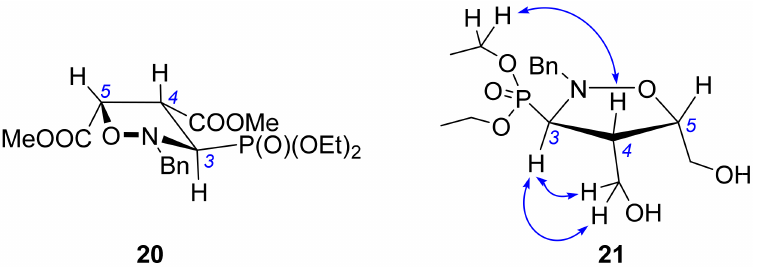
Figure 3. The preferred conformation of 20 and the most important NOESY correlation for phospho- nate 21 (blue